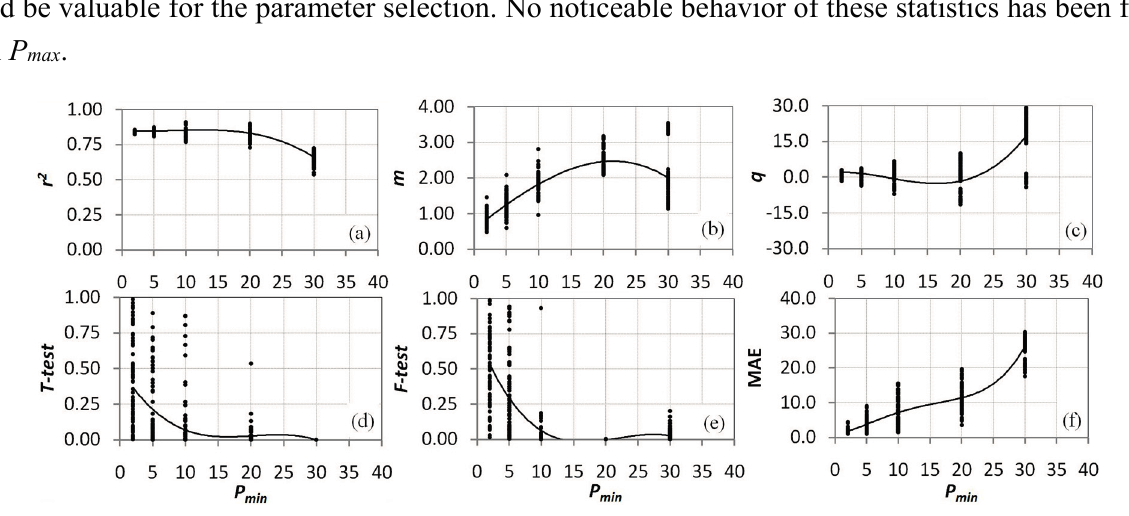
Figure 5. Variability with P min of some statistical parameters used to characterize in situ vs. remote sensing θ : ( a ) determination coefficient r 2 , top left panel; ( b ) slope m , upper central panel; ( c ) intercept q , upper right panel; ( d ) Student test T-test , lower left panel; ( e ) Fisher test F-test , lower central panel; ( f ) mean absolute error MAE, lower right panel; An interpolation line is reported in black.